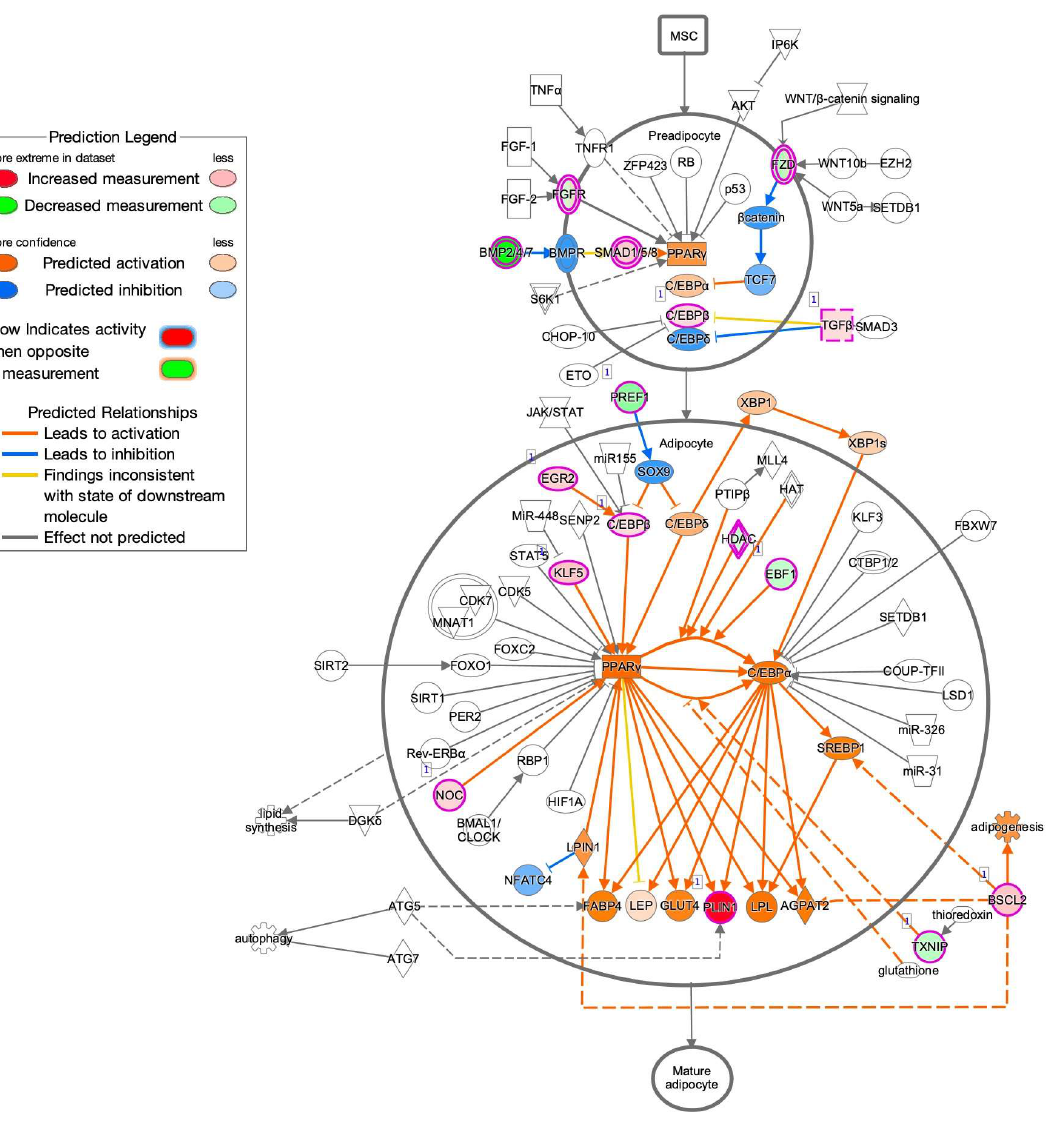
Figure 3. Possible networks of adipogenesis-related signaling during the maturation of adipocytes obtained by the IPA analysis database.